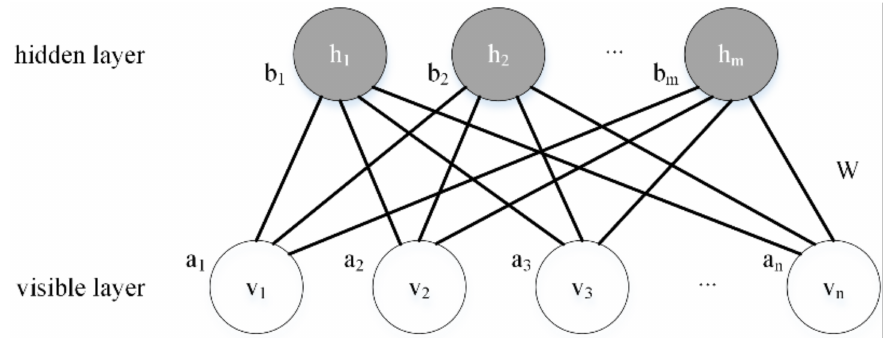
Figure 4. The structure of the